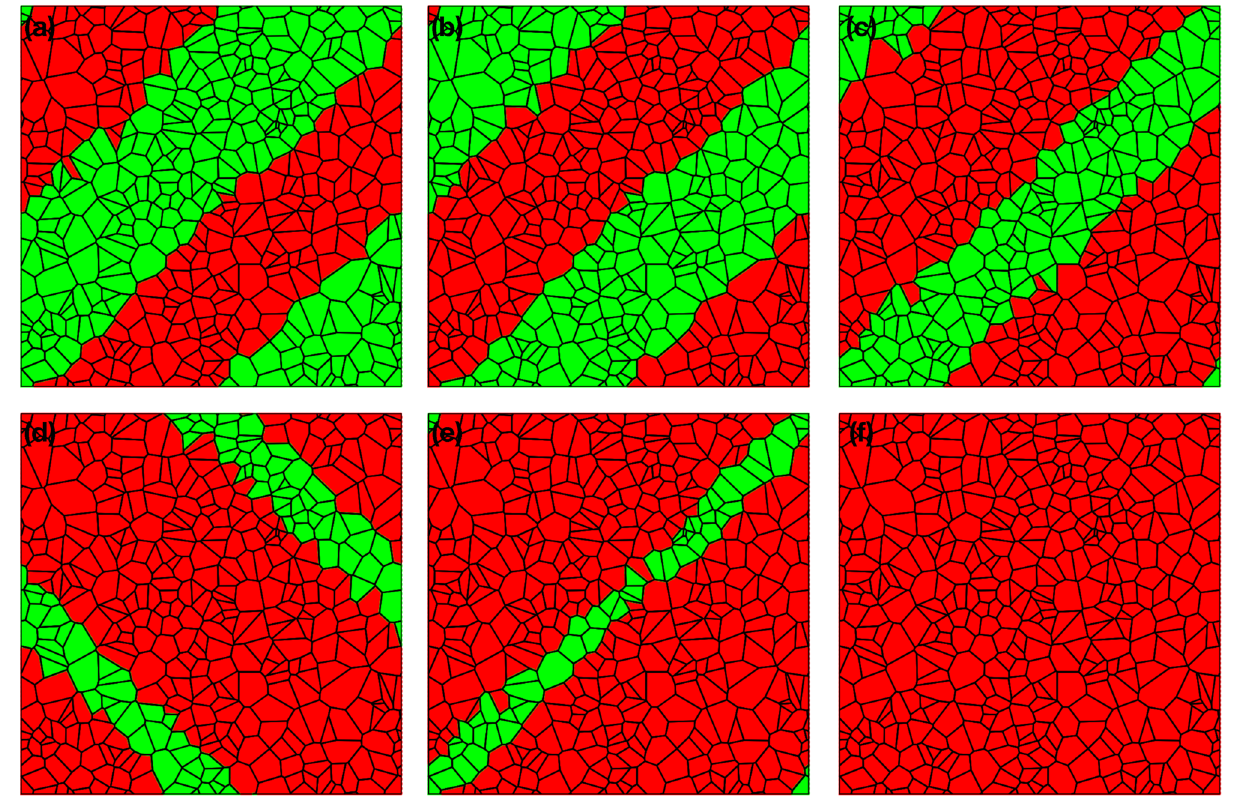
Figure 4. Resulting equilibrium variant distribution with uniform grain orientation. The microstructures consist of 400 grains and tensile strain is applied in horizontal ( x ) direction. Red (green) grains correspond 1 ( s 1 ). The tensile strain is ( a ) to variant s i i = − = +